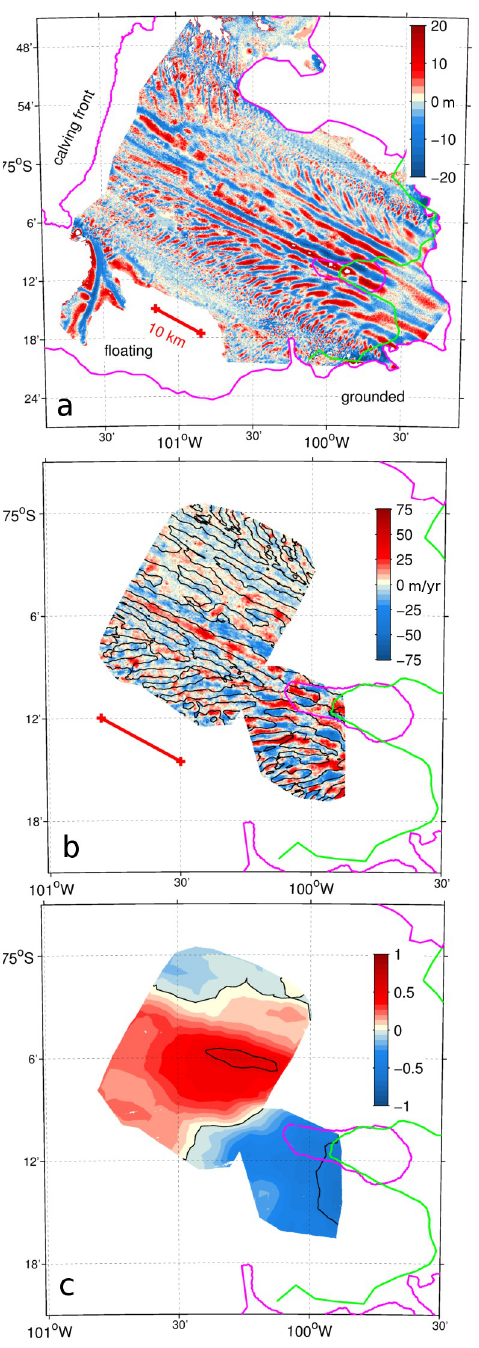
Fig. 3. High-pass filtered (a) SPIRIT surface elevation and (b) basal melt. In (b) , overlaid black contours indicate 0m surface elevation anomaly from (a) after co-registration with the airborne DEM. (c) Correlation (colour and black contours with 0.5 intervals) over mov- ing 4km 2 square boxes between surface elevation and basal melt anomalies in (b) . Negative (positive) correlation indicates basal melt in subglacial channels (keels between